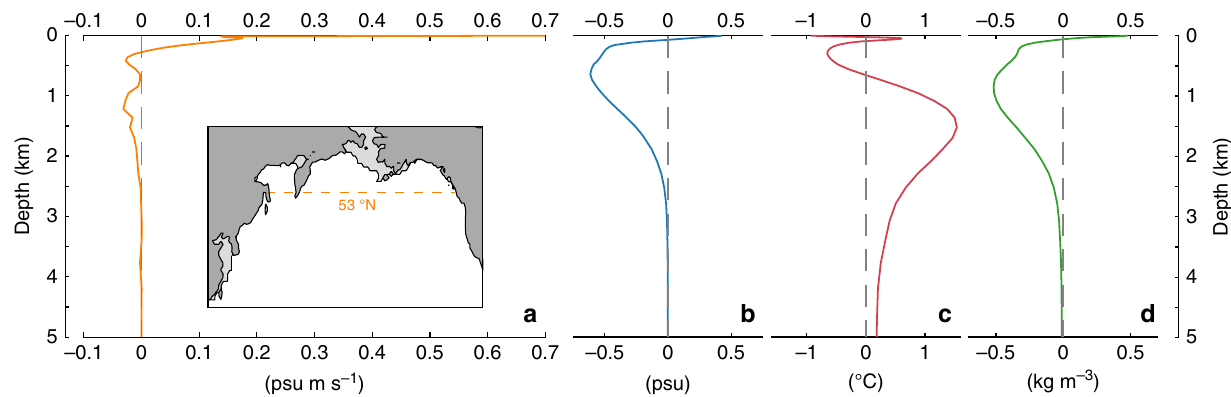
Fig. 4 Modelled anomalies in the vertical pro fi les of the North Paci fi c Ocean and its marginal seas. a Northward salt fl ux averaged at 53°N across the entire North Paci fi c basin. The salt fl ux is calculated by multiplying salinity and meridional velocity, with the northward fl ux in positive values (see change in salinities and velocities at 53°N in Supplementary Fig. 5). b – d show the anomalies of the salinity, temperature and density averaged in the Okhotsk and west Bering Seas of the modelled HS-1 compared to LGM